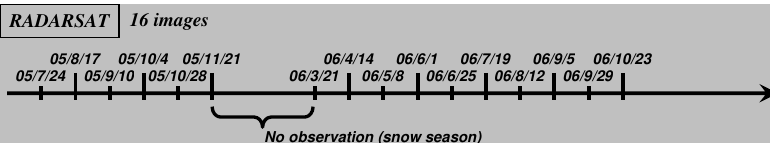
Figure 3. Radarsat data used for the study Fig. 3. Radarsat data used for the study.